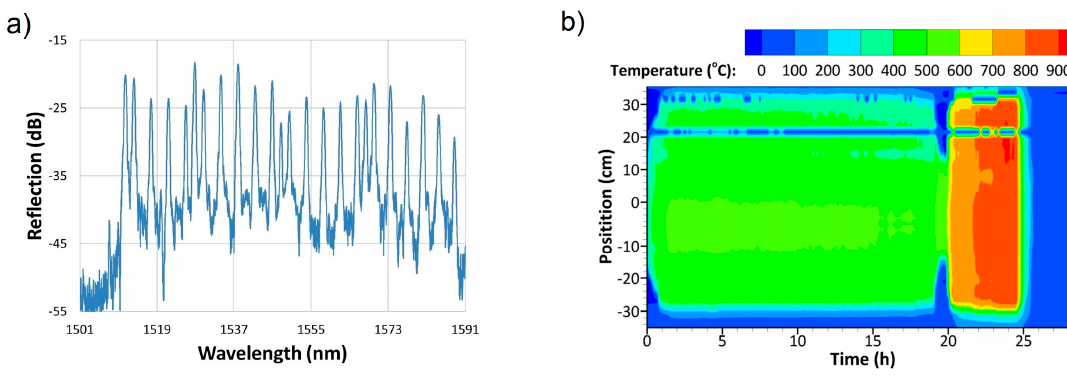
Figure 8. ( a ) Room temperature reflection spectra from a single fiber array after one thermal cycle of combustor; ( b ) Fluidized bed combustor temperature as a function of position and time, during part of one thermal cycle, plotted with 10-min resolution. Data from 3 fiber arrays with 2-cm sensor spacing are shown.